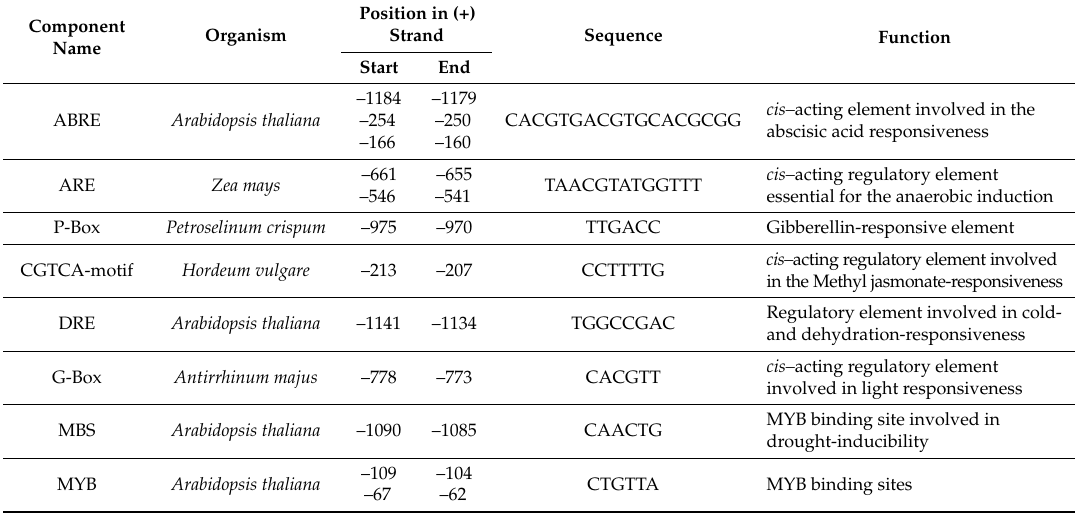
Figure 1. Analysis of the deduced amino acid sequences of B. rapa lipid transfer protein 2 (BraLTP2) with homologous sequences in other Cruciferae . Variable sites (dark grey), the nsLTP-like conserved 8 CM domain (light gray) with conserved cysteine residues (asterisks), and putative extracellular secretory signals (underlined) have been displayed. The sequences are from Arabidopsis thaliana AtLTP1 (AT1g52415.1), B. oleracea BolLTP1 (Bol019670), B. napus BnaLTP1 (BnaAnng31360D), and B. rapa BraLTP2 (Bra040156). Table 1. The putative cis -acting regulatory elements in the promoter of BraLTP2